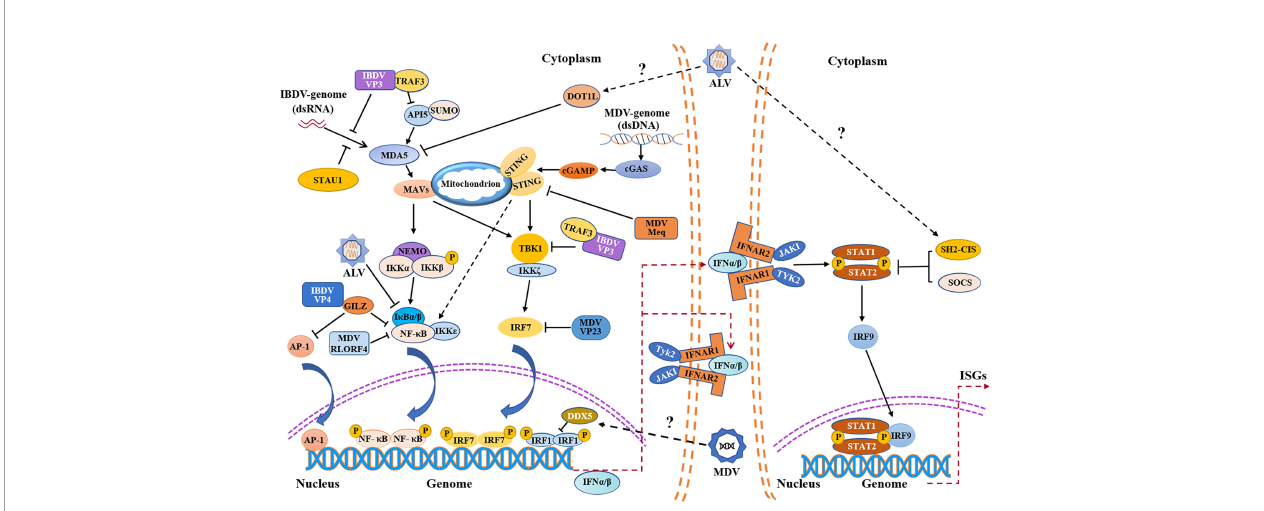
FIGURE 1 | Schematic diagram of avian immunosuppressive viruses evading innate immune response in chicken. Evasion of the PRRs-mediated type I interferon signaling pathway and IFNAR-JAK-STAT signaling pathway by IBDV, MDV, ALV etc. IBDV, MDV and ALV exploit both viral and host proteins to evade innate immune response. IBDV and ALV mainly evade the innate immunity by inhibiting MDA5-mediated signaling pathway, while MDV evades the innate immunity by inhibiting cGAS-STING signaling pathway. IFN a / b promote the expression of ISGs by autocrine and paracrine action. MDA5, melanoma-differentiation-associated gene 5; API5, apoptosis inhibitor 5; TRAF3, tumor necrosis factor receptor associated factor 3; STAU1, staufen1; MAVS, mitochondrial antiviral signaling protein; NF- k B, nuclear factor-kappa B; NEMO, nuclear factor (NF)-kappaB essential modulator; IKK a , NF-kappaB kinase subunit alpha; IKK b , nuclear factor kappa-B kinase beta; I k B a / b , nuclear factor kappa-B- a / b ; IKK z , nuclear factor kappa-B kinase zeta; IKK ϵ , nuclear factor kappa-B kinase epsilon; AP-1, activating protein-1; GILZ, glucocorticoid-induced leucine zipper; DOT1L, disruptor of Telomeric silencing 1-like; cGAMP, cyclic GMP-AMP; cGAS, cyclic GMP-AMP synthase; STING, stimulator of interferon genes; TBK1, TANK-binding kinase 1; IRF, interferon regulatory transcription factor; IFNAR, interferon- a / b receptor; JAK1, Janus kinase 1; TYK2, tyrosine kinases 2; STAT, signal transducers and activators of transcription; SOCS, suppressor of cytokine signaling; SH2-CIS, Cytokine-inducible Src homology 2 -containing protein; ISGs, interferon-stimulated genes; P, phosphate; SUMO,